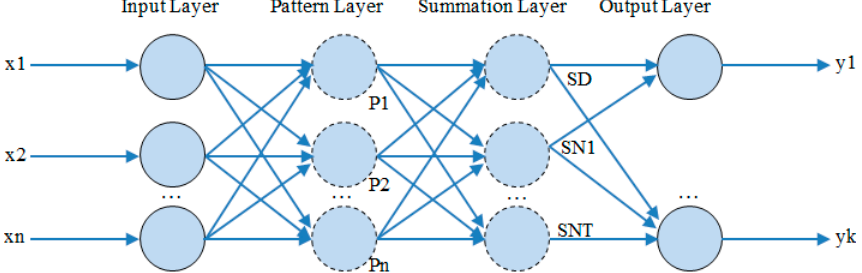
Figure 4. Structure of GRNN for predicting the monthly GRACE TWSAs from January 1985 to March 2002. The input layer xn is the combination of mean precipitation and temperature from in situ observations and SMS from the Noah hydrological model; n is the number of input variables. The output layer yk is the time series of the predicted monthly GRACE TWSA and k is the time span on a monthly scale. Pn, SD, and SNT are the neuronal transfer functions between layers.